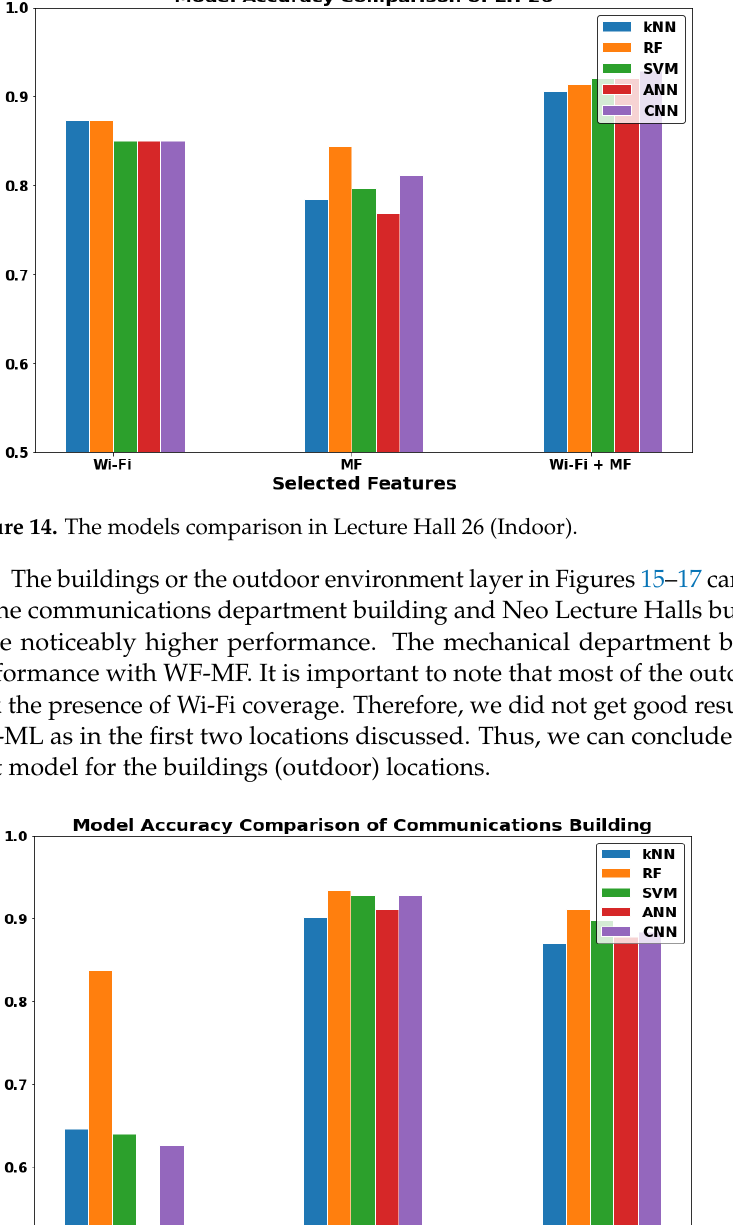
Figure 13. The models comparison in Mech 606 LH (Indoor).